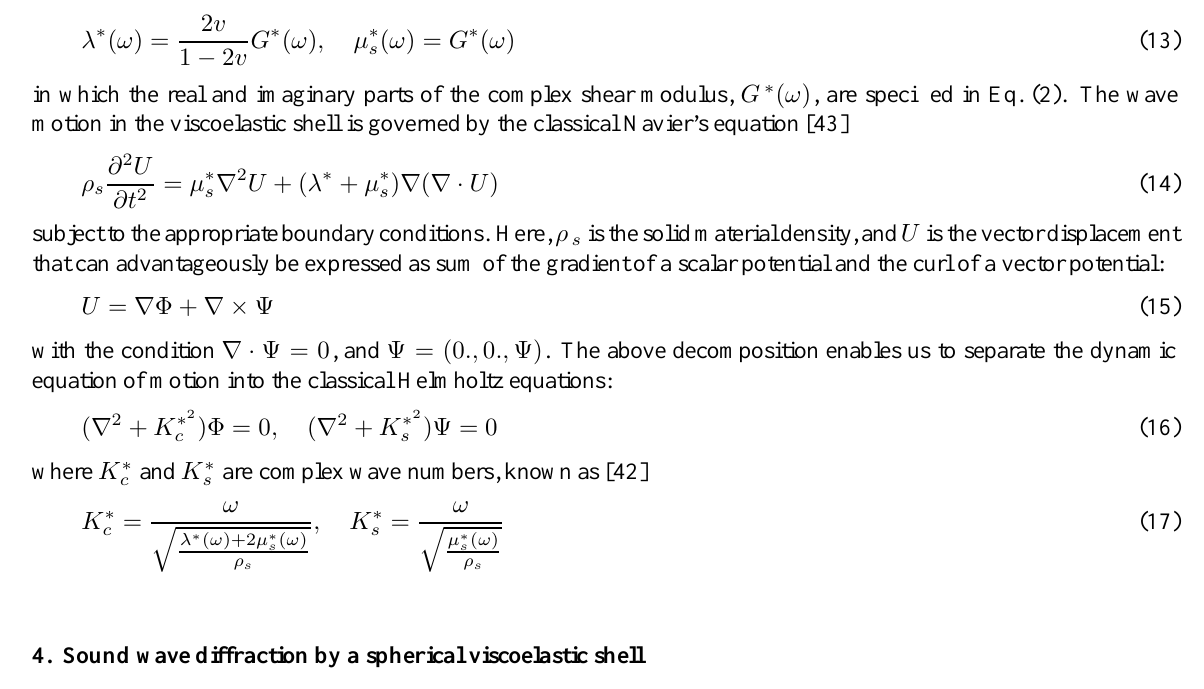
Fig. 1. Problem geometry; a) Spherical coordinate system, b) Cylindrical coordinate